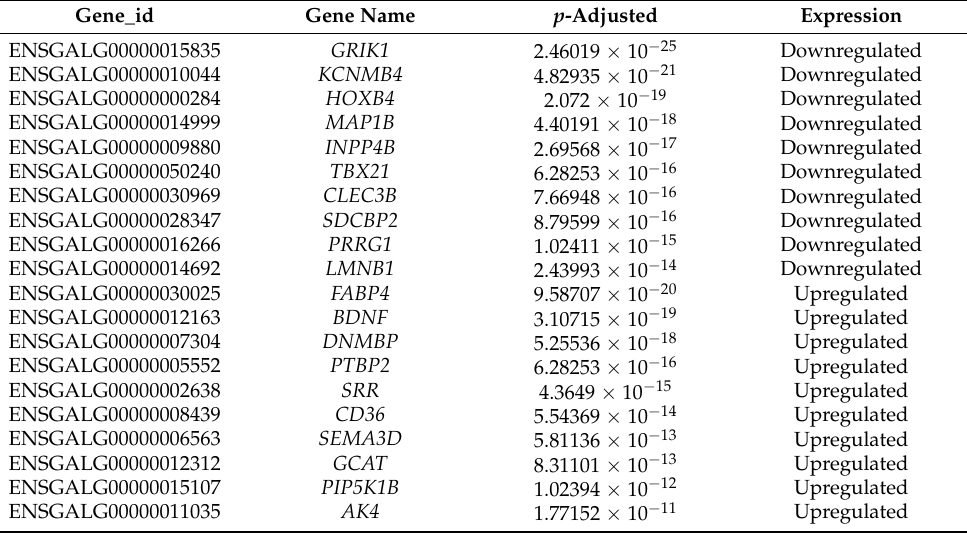
Figure 3. ( A ) Volcano map of differential expression. The red dots indicate significantly up-regulated genes, the green dots indicate significantly down-regulated genes, and the gray dots are nonsignificantly different genes. ( B ) Clustering heat map of differentially expressed genes in group N and group C. Red indicates high, and blue indicates low expression levels. N1, N2, and N3 indicate three parallel samples in the normal group. C1, C2, and C3 indicate three parallel samples in the multifactor ascites group. Table 6. Top ten up-regulated and down-regulated genes in group C compared to group N.